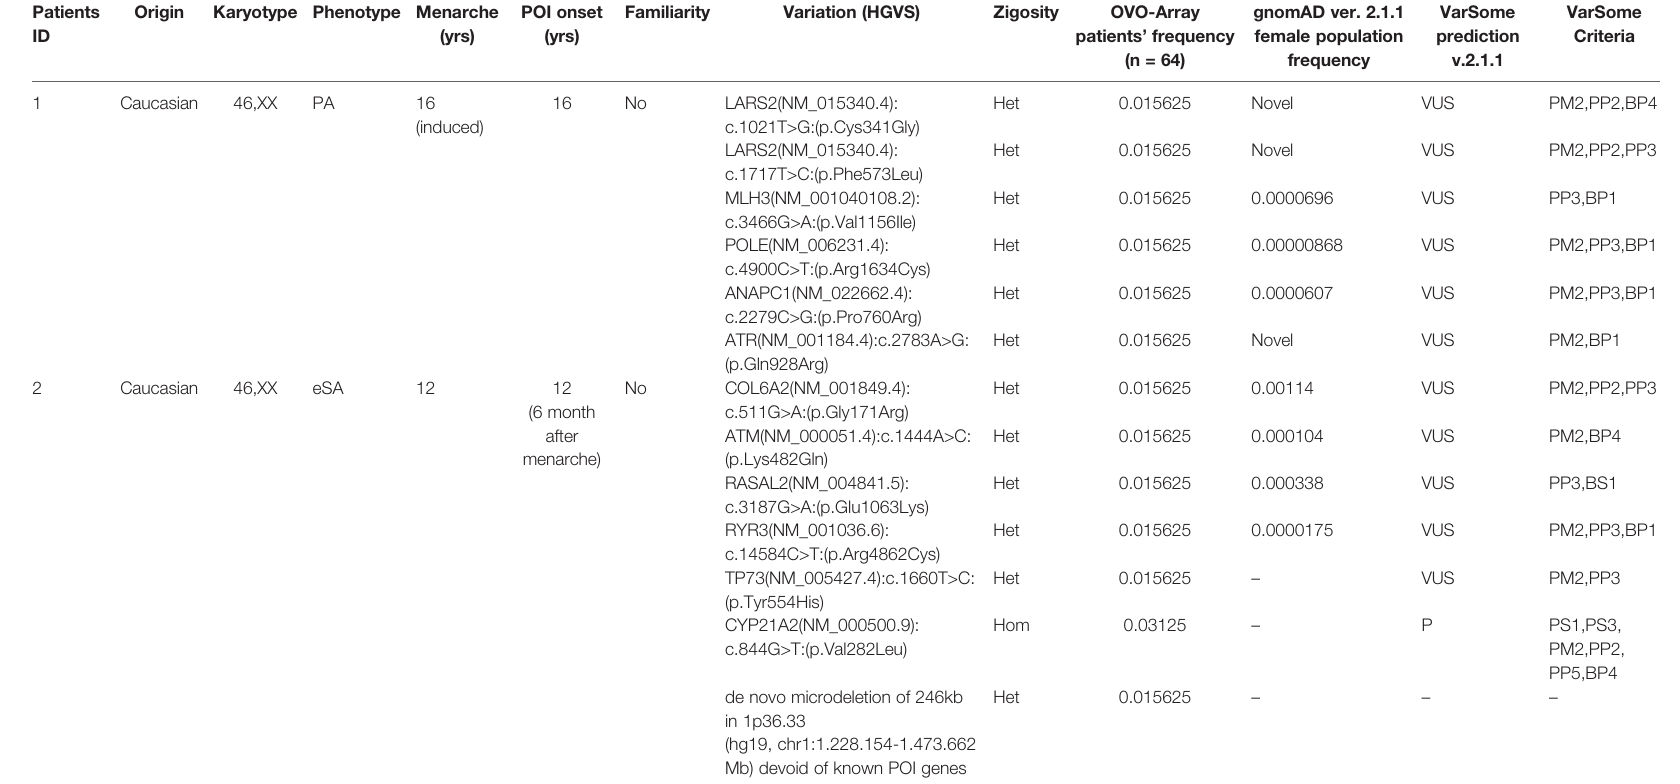
TABLE 1 | Correlation among severity, phenotype and pathogenicity predictions in patients with 6 variants in potentially POI